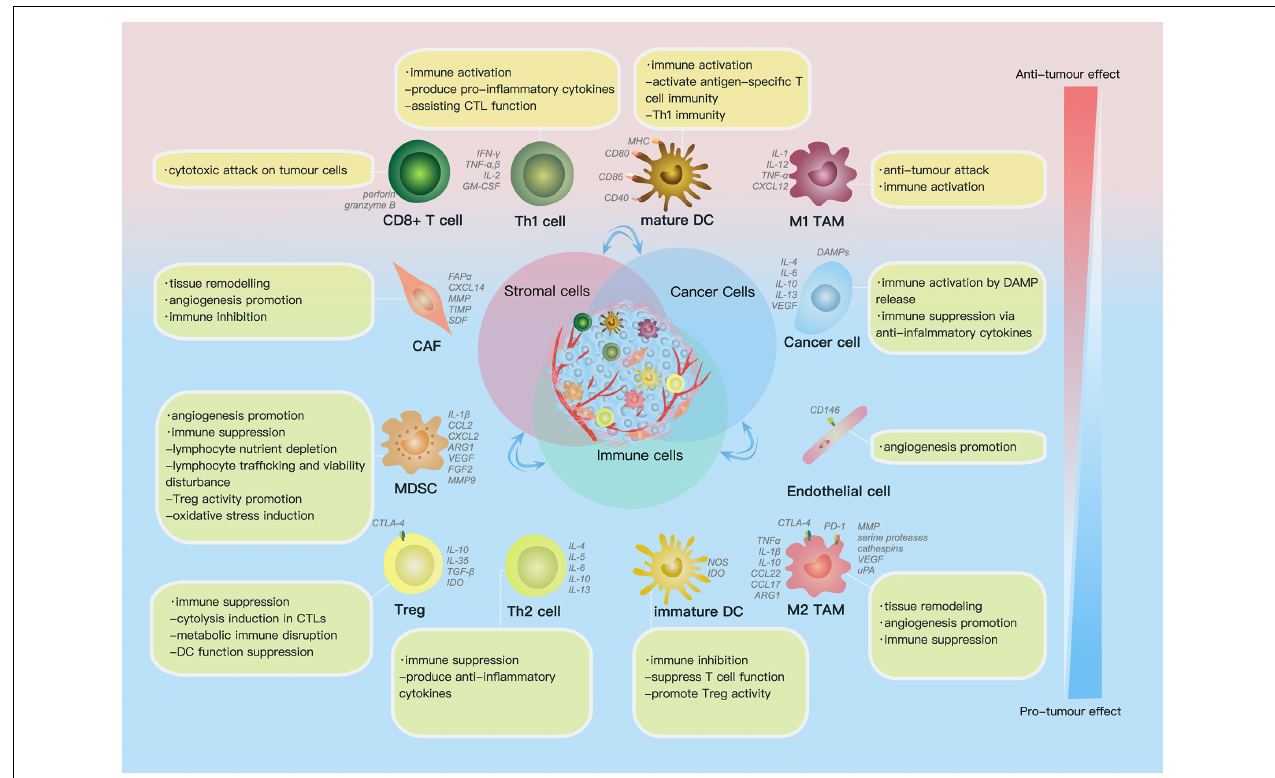
FIGURE 1 | Cell components and functions in the tumor microenvironment (TME). Cell components in the TME can be classified into cancer cells, immune cells and stromal cells; these cells actively interact with each other by molecules they secrete [including cytokines, chemokines, damage-associated molecular patterns (DAMPs) etc.] and receptors they express, such as histocompatibility complex class (MHC) molecules, programmed cell death protein 1 (PD-1), etc., forming an evolving microenvironment. On the continuous spectrum from anti-tumor to pro-tumor effect, different cell components can locate at distinct positions, and the same group of cells may also be re-polarized depending on signals in the TME. The progression or regression of a single tumor site depends on the overall effect of the complex cellular and molecular regulating network in the TME.